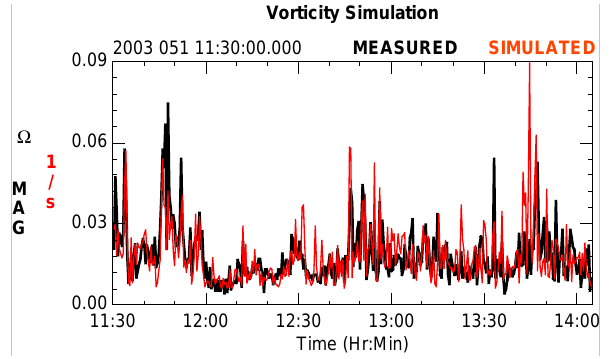
Fig. 11. Measured electron vorticity (black) compared with the vorticity which would be produced by changes in a constant field aligned velocity across the four spacecraft.